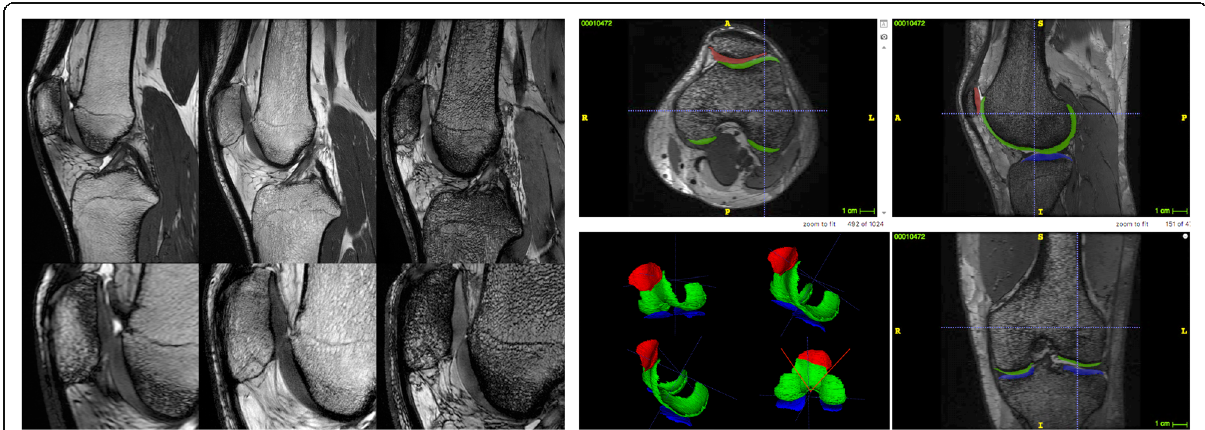
Fig. 1 At the top left, the comparison of the same knee of the same healthy volunteer acquired with fast imaging employing steady-state acquisition with coherence interference (FIESTA-C) at 1.5-T, 3-T, and 7-T (from left to right), showing the improved spatial and contrast resolution for cartilage visualisation. At the bottom left, a detail of the comparison of the femoral-patellar compartment at 1.5-T, 3-T, and 7-T is displayed (from left to right). On the right, an example of semiautomatic segmentation of the different cartilage compartments of the knee is depicted with multiplanar reformation and corresponding volume rendering of the segmented cartilage (red, patellar cartilage; green, femoral cartilage; blue, tibial cartilage). Images were acquired at the University Hospital of Cisanello, Pisa, Italy (1.5-T and 3-T) and at the Imago7 Foundation, Pisa, Italy (7-T). Adapted with permission from Aringhieri et al, Clin Exp Rheumatol 2018. Segmentations were performed with ITK-SNAP